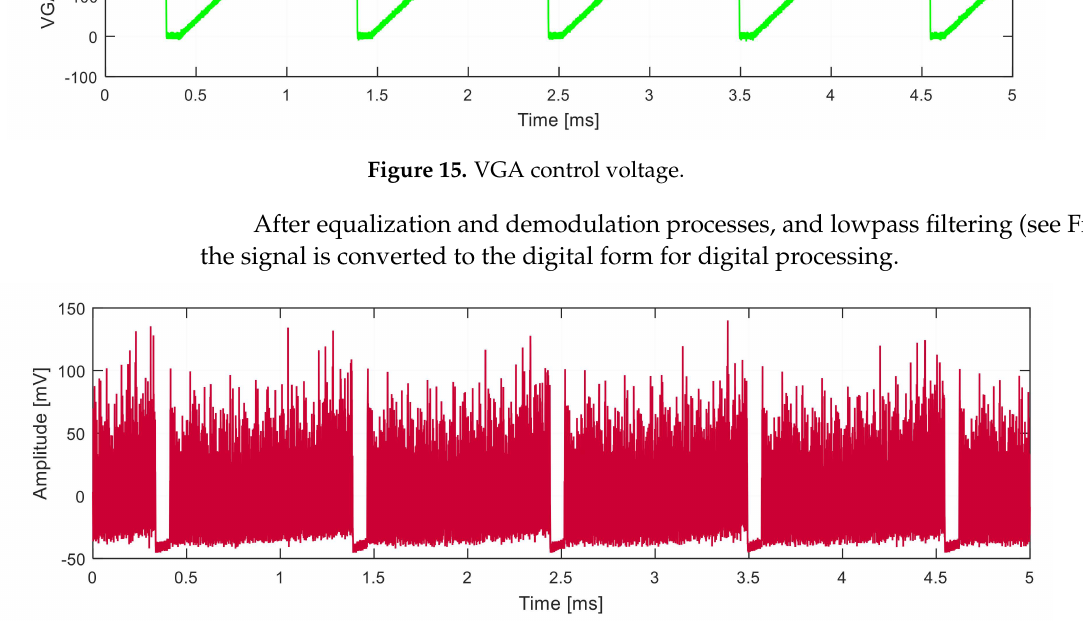
Figure 16. Signal after demodulation and